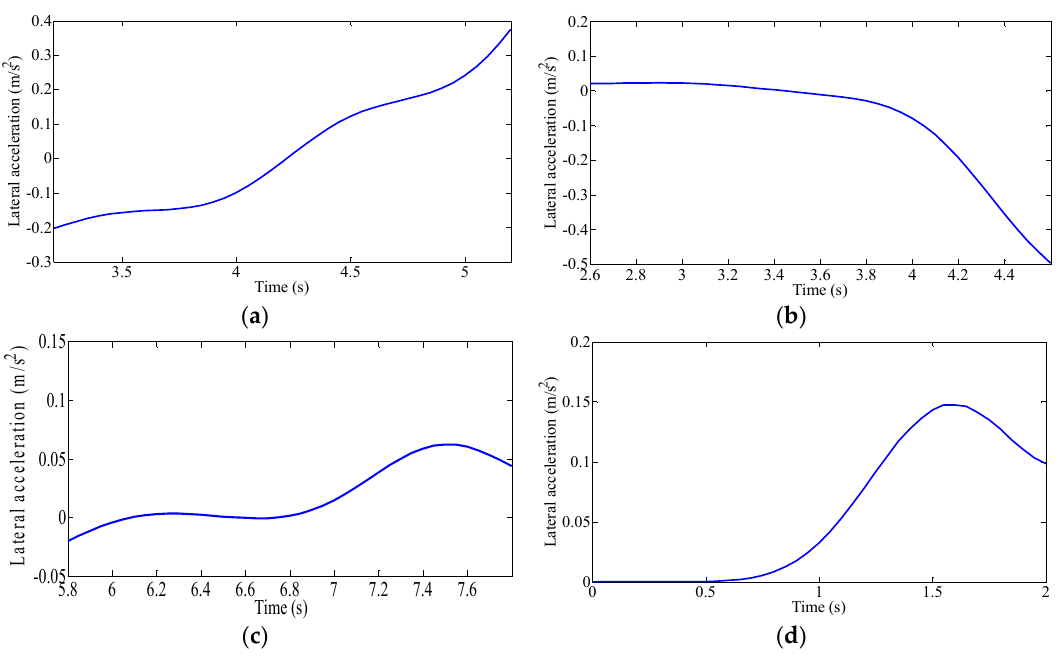
Figure 8. Lateral acceleration under different steering conditions: ( a ) turning right; ( b ) U-turn; ( c ) lane keeping; ( d ) lane changing.